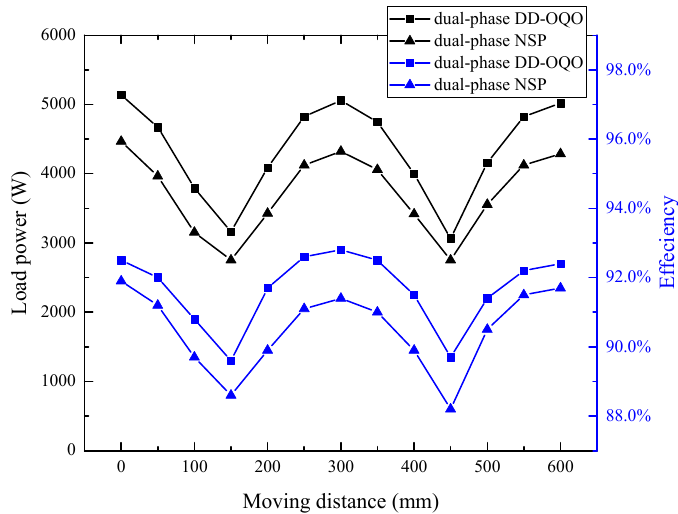
Figure 13. Output characteristics of the two receivers under different moving distances.